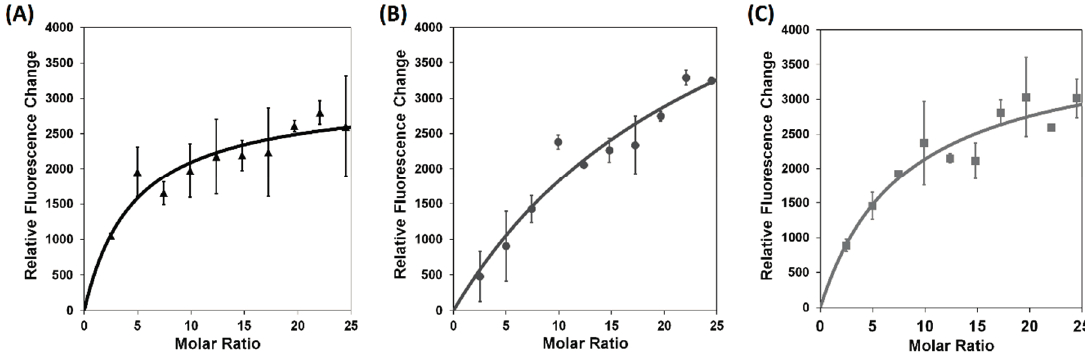
Figure 2. Interaction of Xanthorrhizol and tadA protein. Tryptophan quenching assay ( A – C ) were used to observe interaction between xanthorrhizol and tadA protein; ( A ) wild type tadA ; ( B ) tadA (A143V); and ( C ) tadA (F149G). The assays showed a response, as revealed